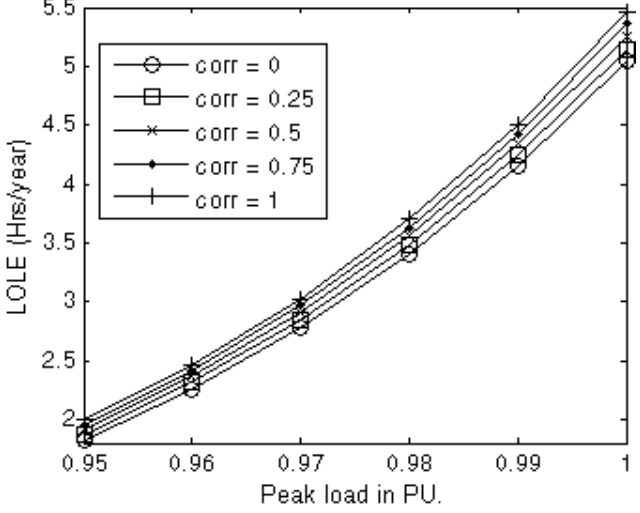
Figure 7. Variation in LOLE with peak load for different correlations.